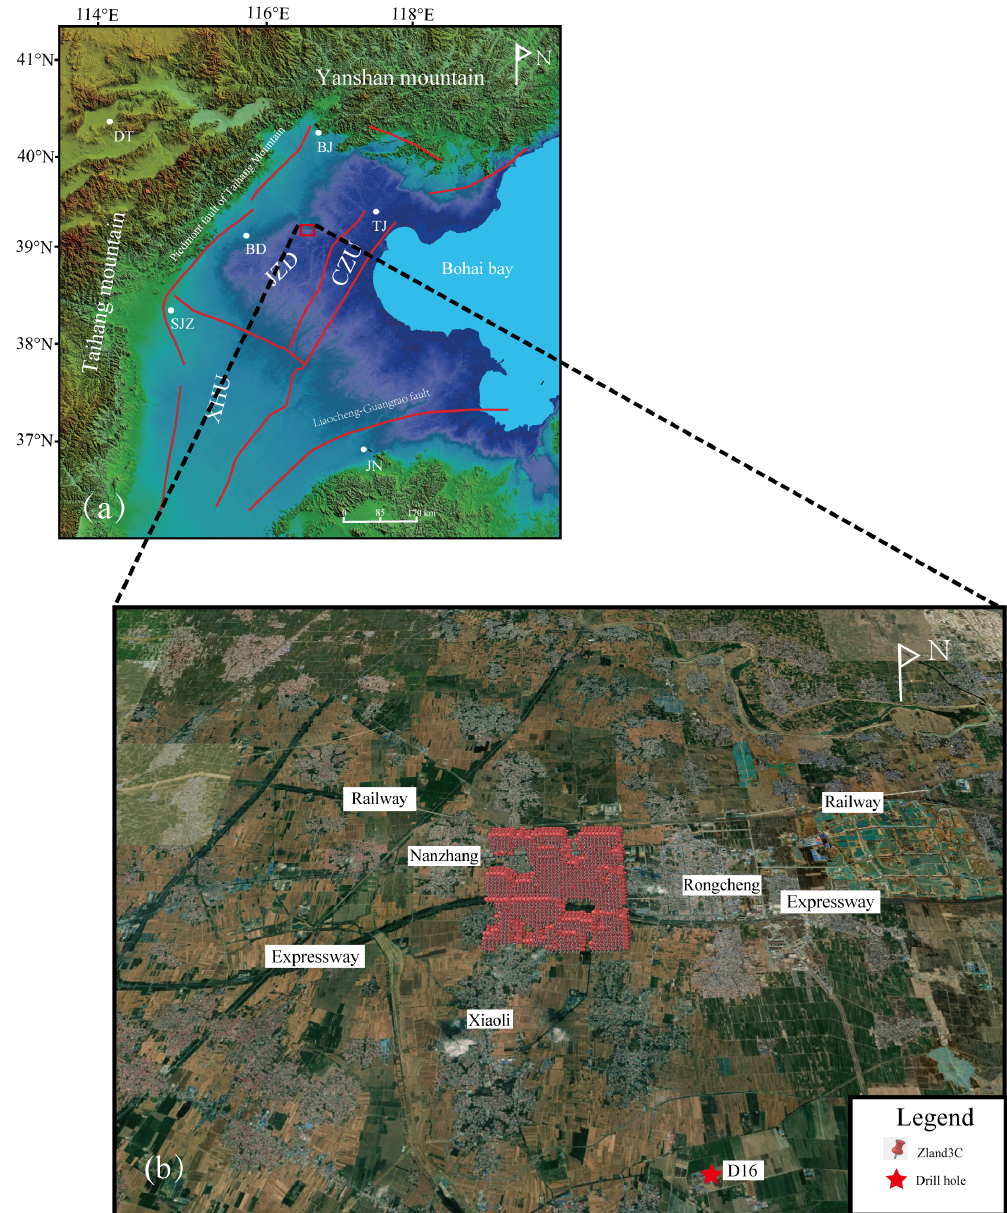
Figure 1. Map of the regional tectonic background of the Jizhong Depression basin and the location of the receiver array (red pushpins) and reference well locations (red star) used in this study. ( a ) Generalized tectonic map of the Jizhong Depression, North China Basin. Main cities: DT—Datong; BJ—Beijing; TJ—Tianjin; BD—Baoding; SJZ—Shijiazhuang; JN—Jinan. Major tectonic units: JZD—Jizhong depression; CZU—Cangxian uplift; XHU—Xingheng uplift. The red rectangle indicates the position of the receiver array. ( b ) Map of the receiver array. The red pushpin shows the location of the receivers, and the red star indicates the reference drillhole (D16). Only two villages (Nanzhang and Xiaoli) and one town (Rongcheng) very near the receiver array are labeled in this